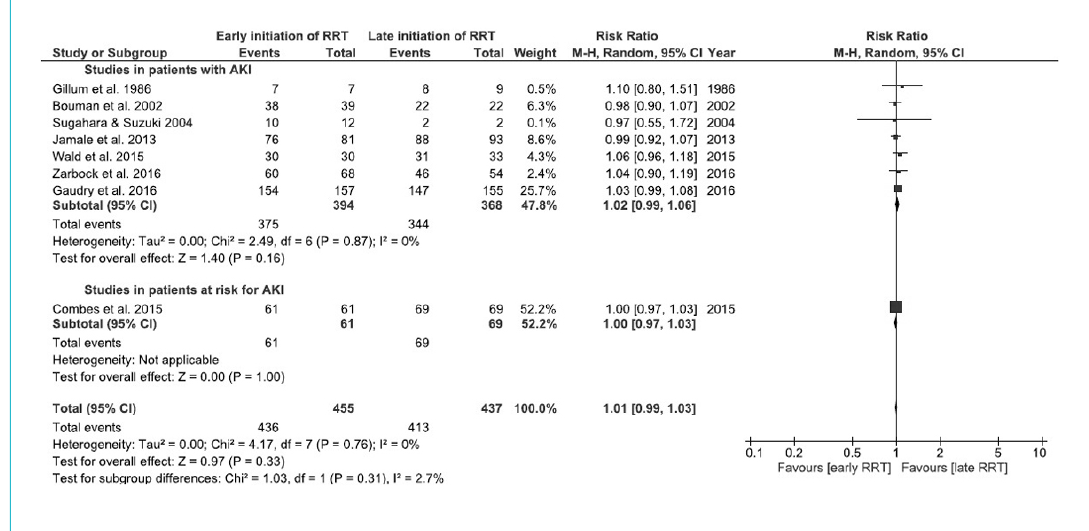
Figure 4: Forest plot demonstrating the impact of early or preventive renal replacement therapy on renal recovery at the end of the study fol- low-up compared with late renal replacement therapy in patients with acute kidney injury (AKI) (seven studies), at risk for AKI (one study), and in all eight studies. Data are presented as risk ratios with 95% confidence intervals. A random-effects model was